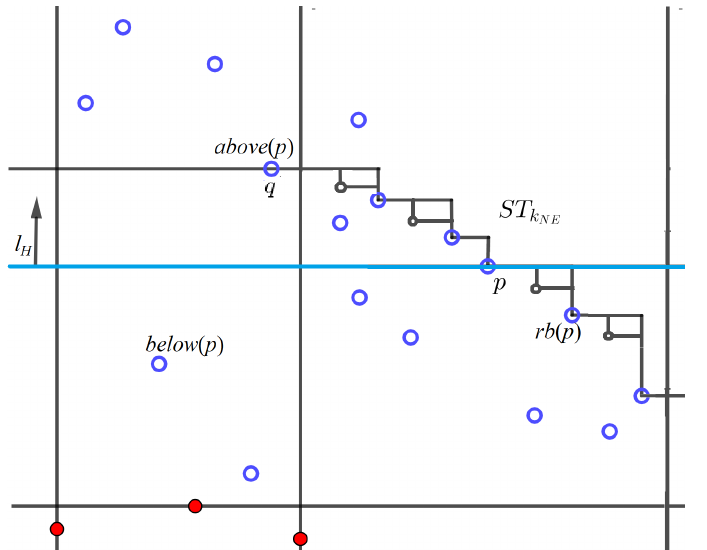
Figure 3. B N ∪ B NNE is swept with a horizontal line l H sliding upwards from the lowest blue point. The set S k is updated at every blue point p encountered. Staircase points that are not blue points NNE are marked with black dots.